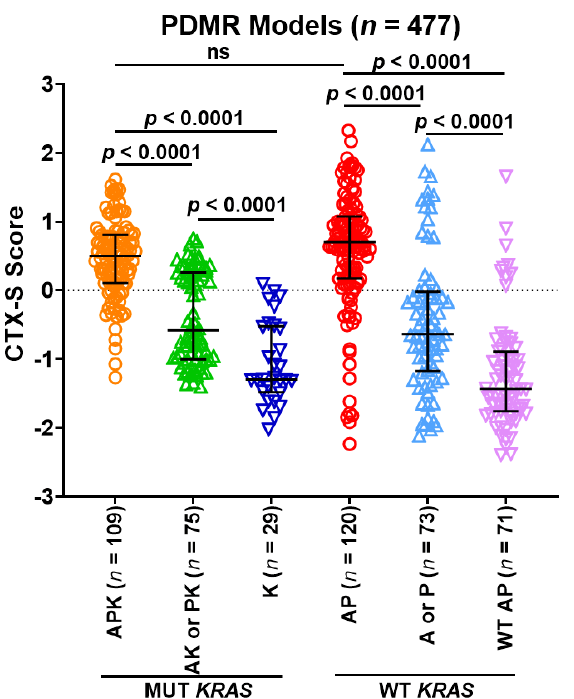
Figure 6. Comparison of CTX-S scores in AP/APK vs. nonAP/APK in each of four CMS classes